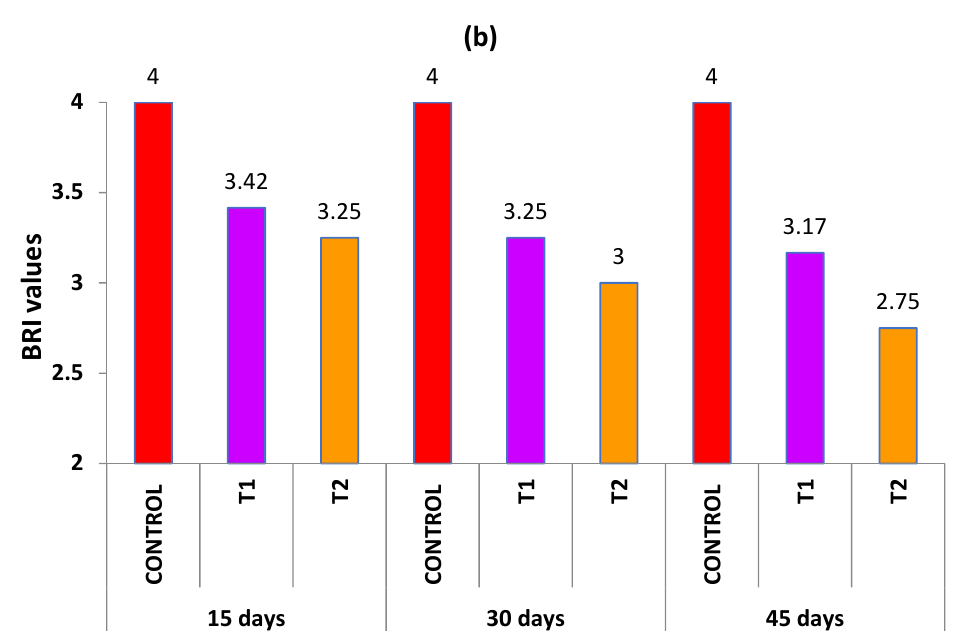
Figure 7. ( a ) IBR values of biomarkers in Clarias batrachus exposed to diazinon for different periods ( b ) BRI values of test fish upon exposure to diazinon for 15, 30, and 45 days.